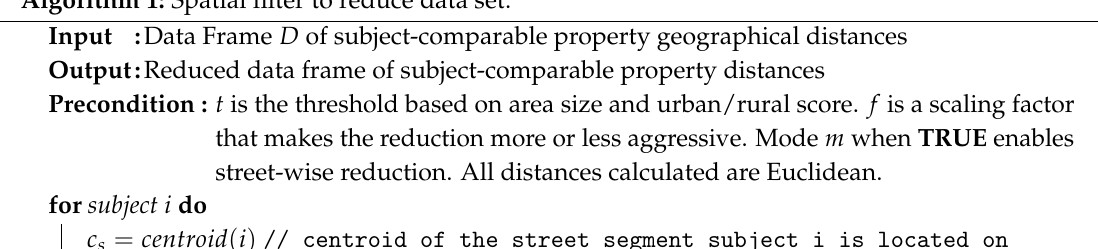
Algorithm 1: Spatial filter to reduce data set.